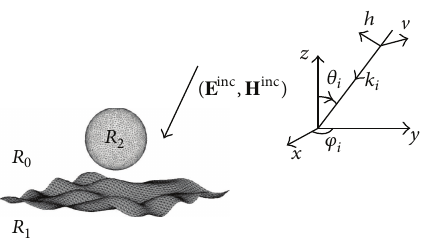
Figure 1: Composite scattering model of target and rough